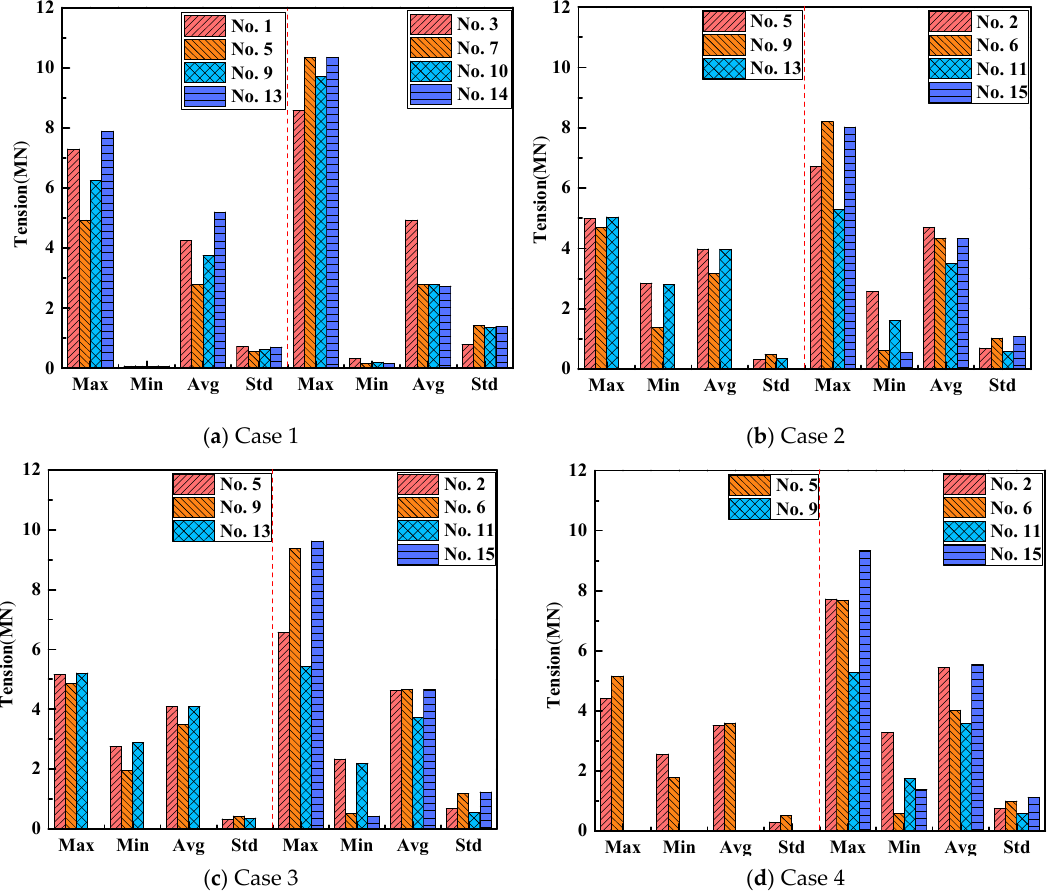
Figure 23. Statistics of tension in mooring lines in conditions with broken mooring lines.